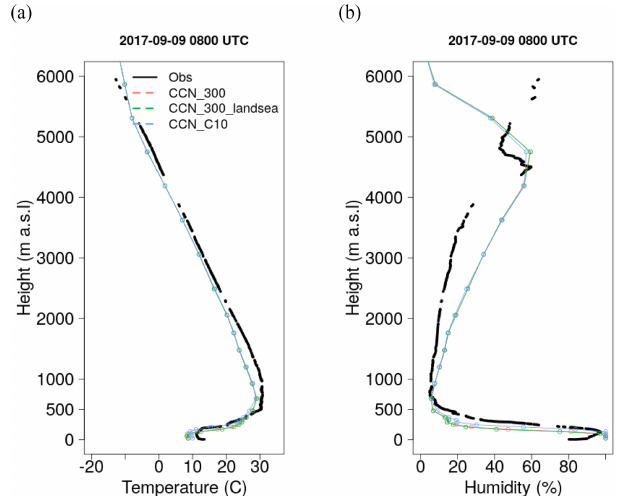
Figure 8. Radiosonde profiles of (a) temperature and (b) relative humidity from Jakkalsputz on 9 September 2017. The sonde was launched at 07:50UTC, and the model is from 08:00UTC. The site is UTC + 2.